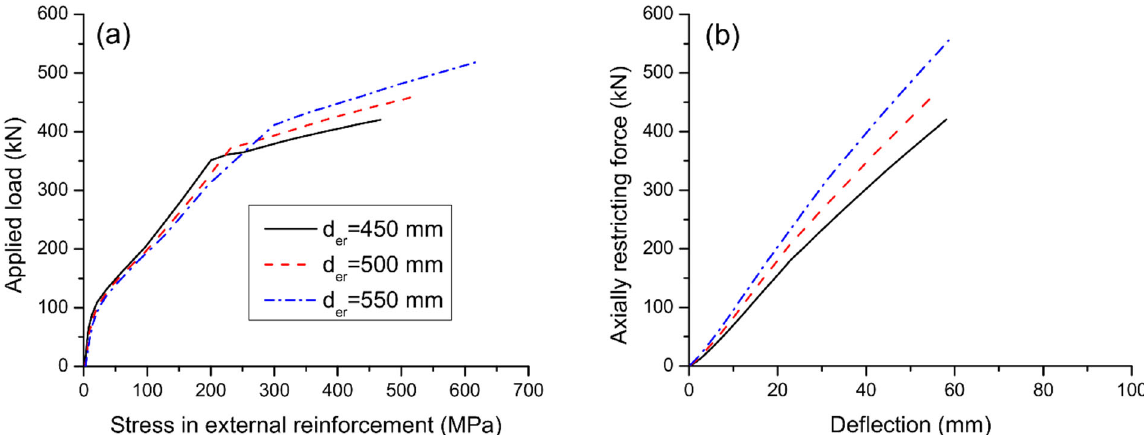
Figure 14. Effect of reinforcement depth on the behavior of external reinforcement. ( a ) load versus reinforcement stress; ( b ) axially restricting force versus midspan deflection.